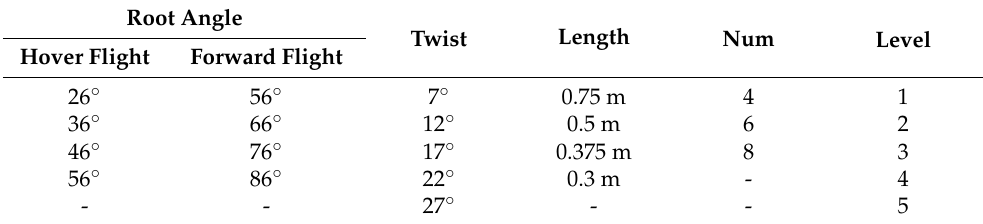
Table 5. Orthogonal parameters field of the rotor disk.